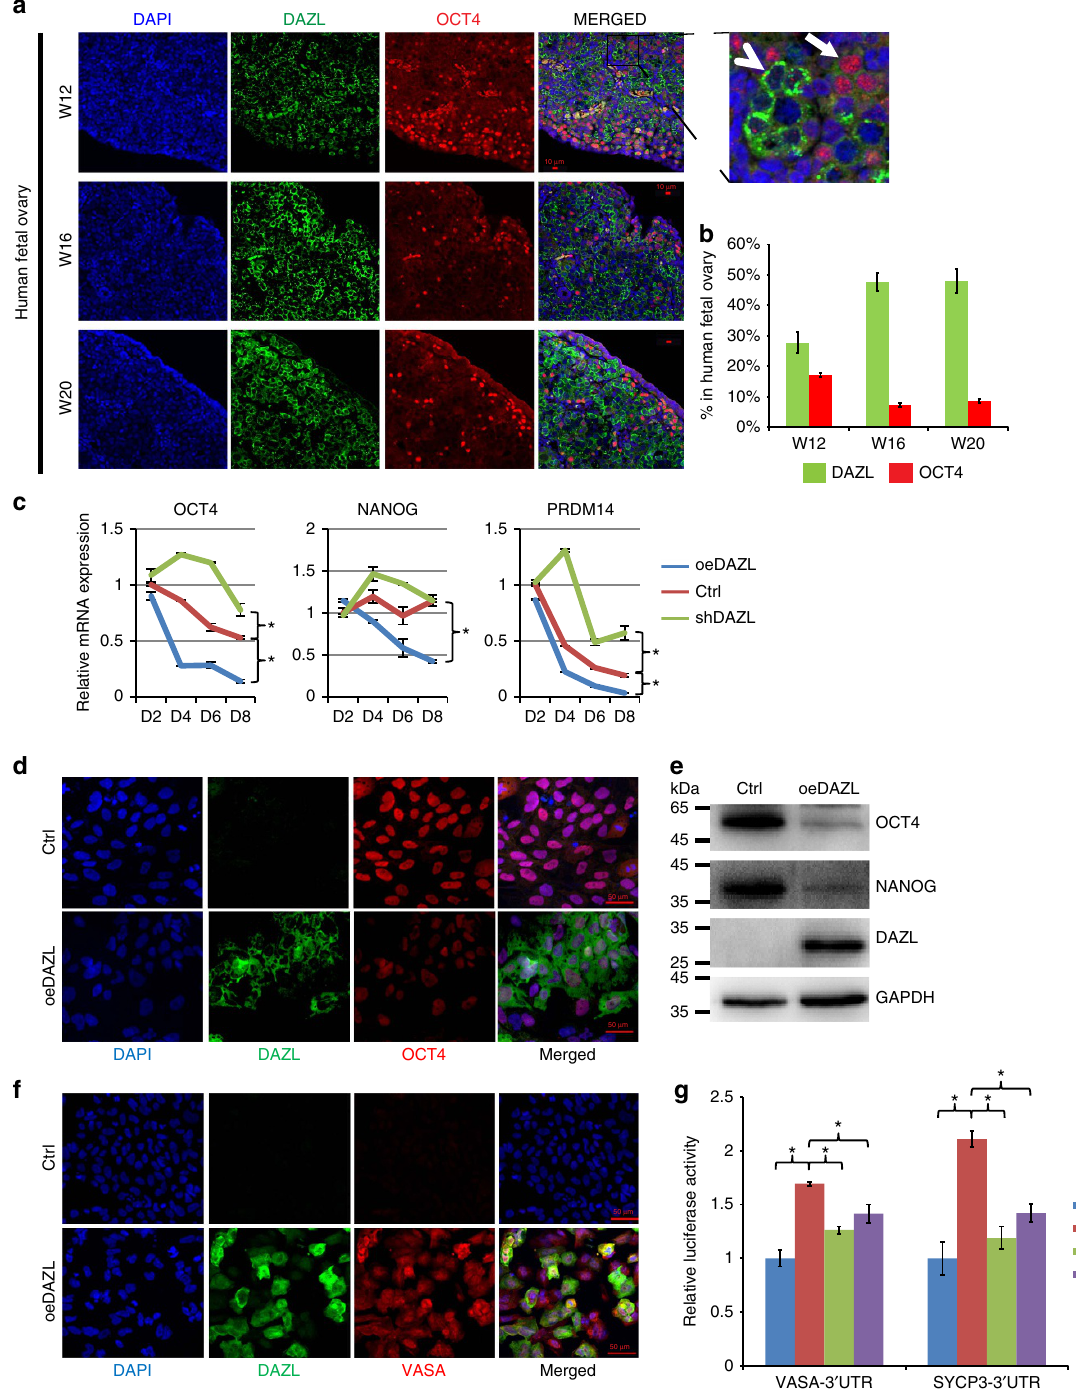
Figure 1 | DAZL regulates the exit from pluripotency and entry into the late PGC stage. ( a ) Immunofluorescent staining of DAZL, OCT4 and DAPI (nuclei) in 12, 16 and 20W human fetal ovaries. A magnified image is shown on the upper right corner. Bar, 10 m m. Arrow: OCT4-positive cells; arrow head: DAZL-strong positive cells. ( b ) Percentages of OCT4-positive cells, and DAZL-strong positive cells in the 12, 16 and 20W human fetal ovaries. n ¼ 500– 800 cells counted in three different fields, error bar is s.d. ( c ) Relative mRNA expression levels of OCT4, NANOG, PRDM14 measured by qPCR in the control (Ctrl), DAZL-overexpressing (oeDAZL) and DAZL-silenced (shDAZL), hESCs differentiated from day 2 to day 8. n ¼ 2 from each time point (replicates from B 100,000 cells), three independent experiments conducted, error bar is s.d., asterisks indicate statistical significance ( P o 0.05, Student’s t -test) between the two samples at the same time-points. ( d ) Immunofluorescent staining of DAZL and OCT4 in the Ctrl and oeDAZL hESCs at day 6. ( e ) Western analysis of OCT4, NANOG and DAZL in the Ctrl and oeDAZL hESCs at day 6. ( f ) Immunofluorescent staining of DAZL and VASA in in the Ctrl and oeDAZL hESCs at day 6. ( g ) 3 0 -UTR Luciferase reporter assays of VASA, and SYCP3 transfected with wild-type or the two DAZL mutants carrying point mutations F84A and R115G. n ¼ 4, (four independent biological replicates per cell populations, B 25,000 cells in each sample), and the experiment had been conducted three times, error bar is s.d., asterisks indicate statistical significance ( P o 0.05, Student’s t -test) between the two